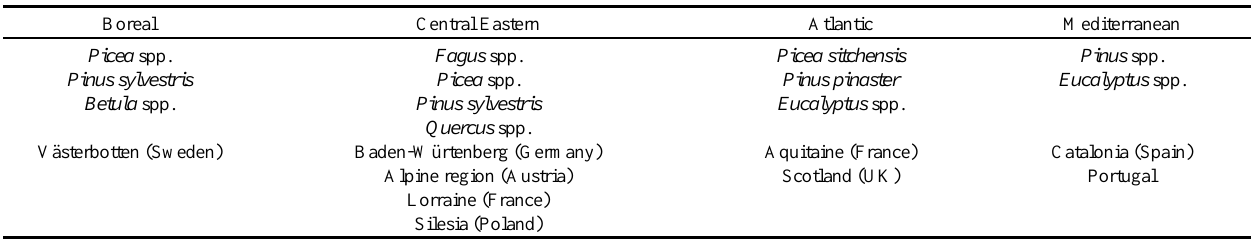
Table 1 . Overview of main tree species and regions considered for defining reference forests within each European biogeographic